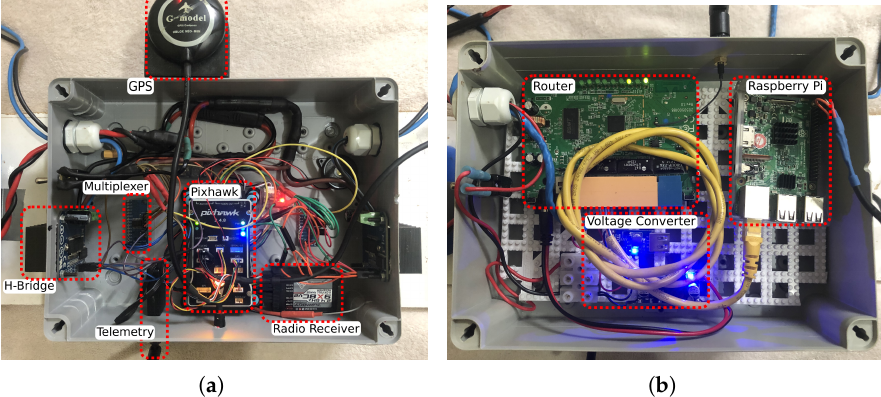
Figure 9. Details of the components present in the control and network systems. ( a ) Control System. ( b ) Network System.